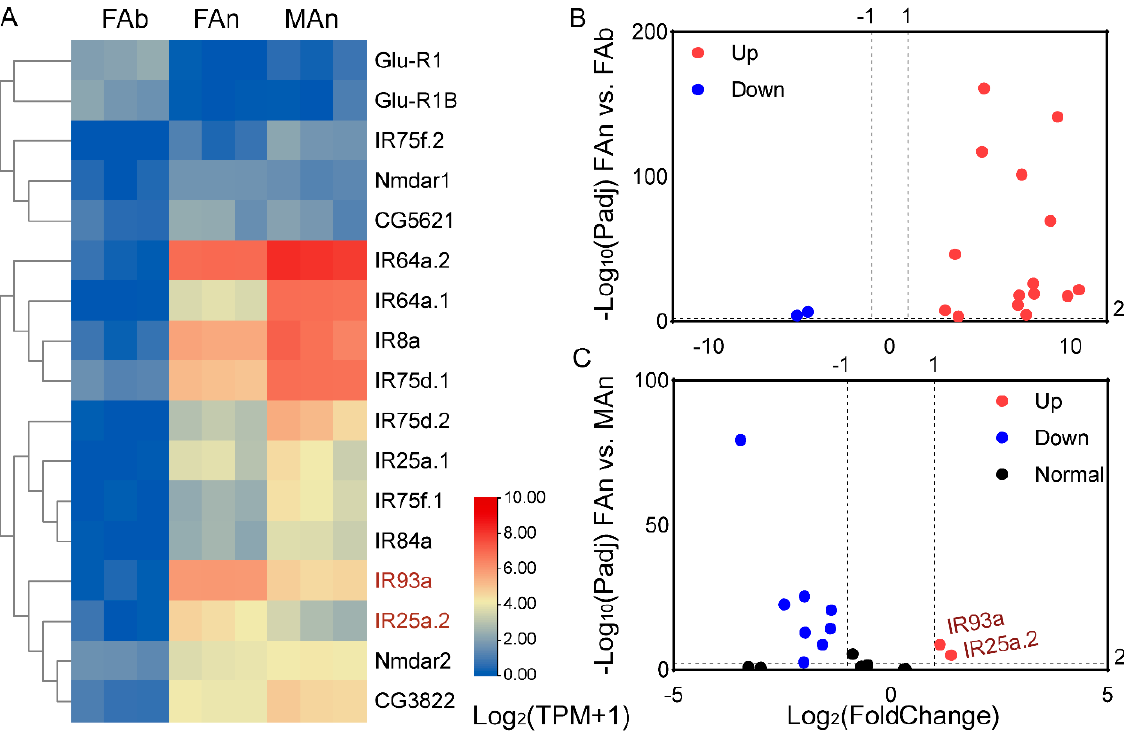
Figure 5. The expression profiles of the AjapIRs. ( A ) The expression levels of the AjapIRs in the female abdomen (FAb), female antennae (FAn), or male antennae (MAn) of Anastatus japonicus . The expression levels of the genes were calculated based on log 2 (TPM+1). ( B ) The differentially expressed genes between the abdomen and antennae of the female (FAn vs. FAb). ( C ) The differentially expressed genes between the female and male antennae (FAn vs. MAn). The adjusted p value < 0.01 and |log 2 (FoldChange)| > 1 were set as the significantly differential expression threshold.